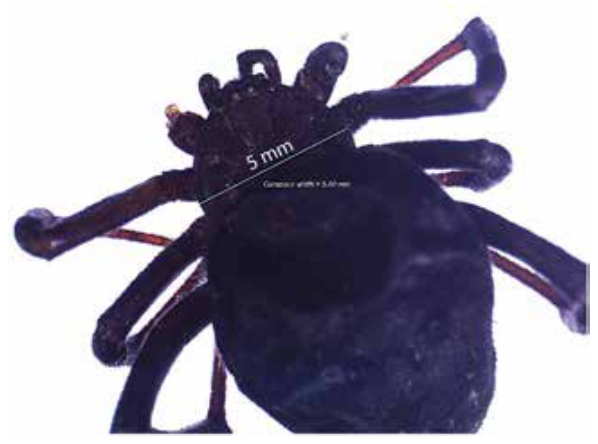
Figure 1: Black widow spider with carapace width.